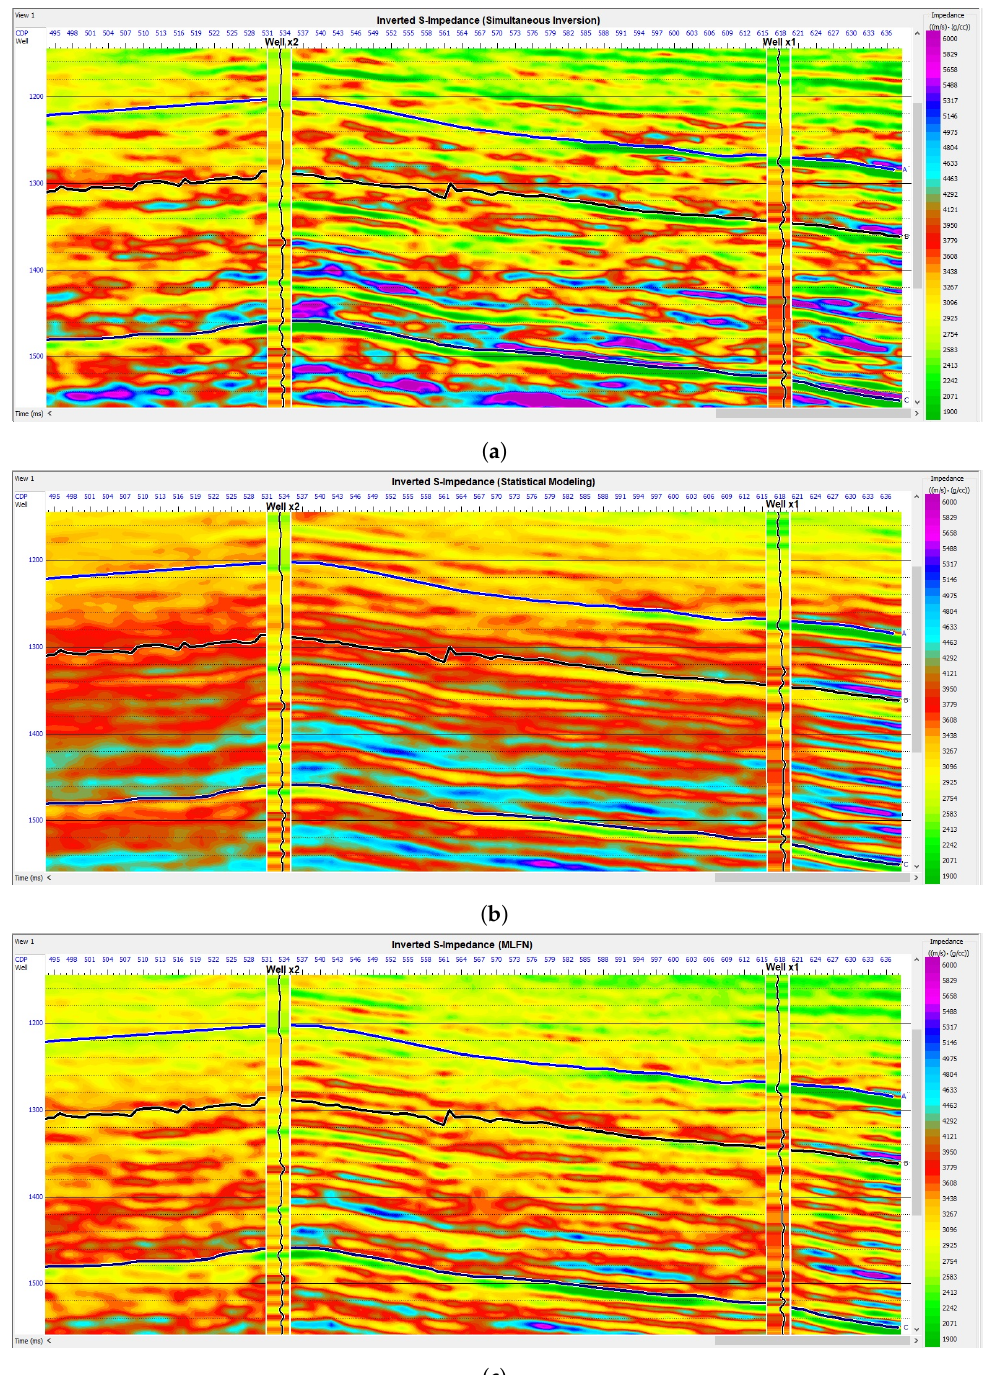
Figure 17. Arbitrary sections extracted from the zero-offset shear impedance volumes obtained from ( a ) isotropic inversion, ( b ) statistical modeling, and ( c ) MLFN. The inserted curves are the shear impedance logs of the wells × 1 and ×